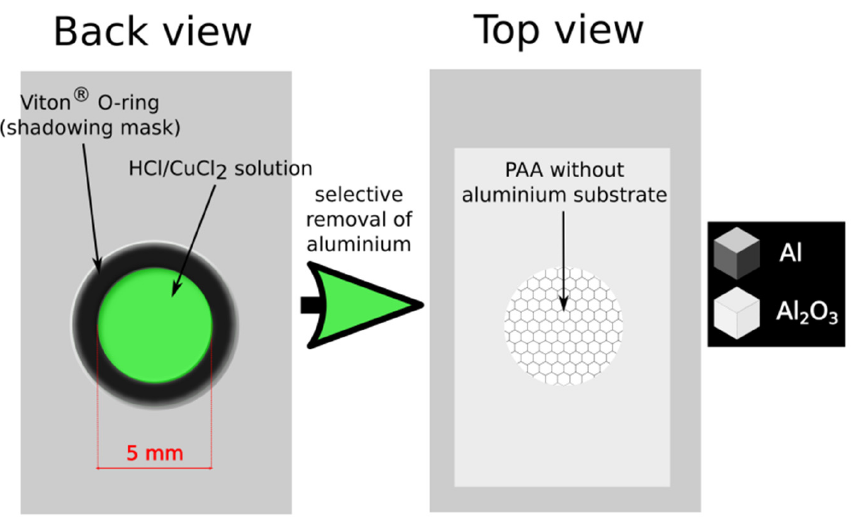
Figure 2. A scheme representing the preparation of a free-standing porous anodic alumina